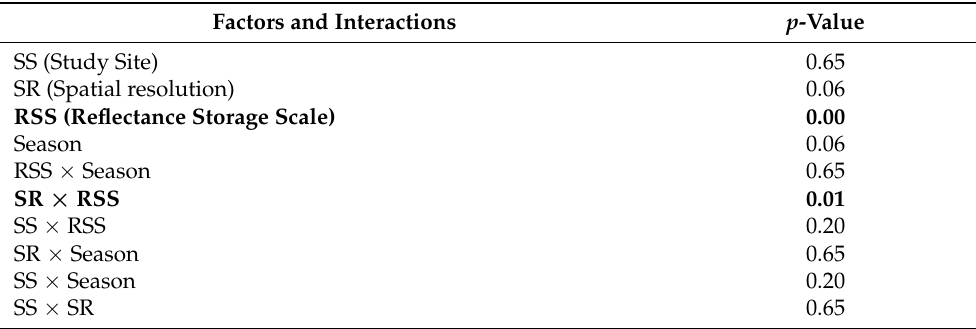
Table 5. Summary of the ANOVA results ( N = 16) for the visual ranking scores (median value). The factors and interactions written in bold were statistically significant ( p < 0.05). Factors and Interactions p